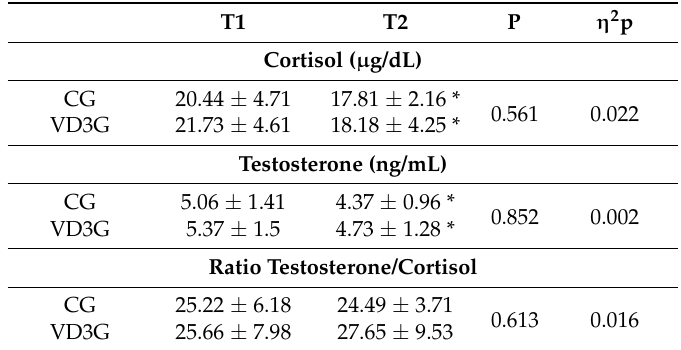
Table 2. Hormonal parameters in the control group (CG) and vitamin D3 treatment group (VD3G) at baseline (T1) and after 8 weeks